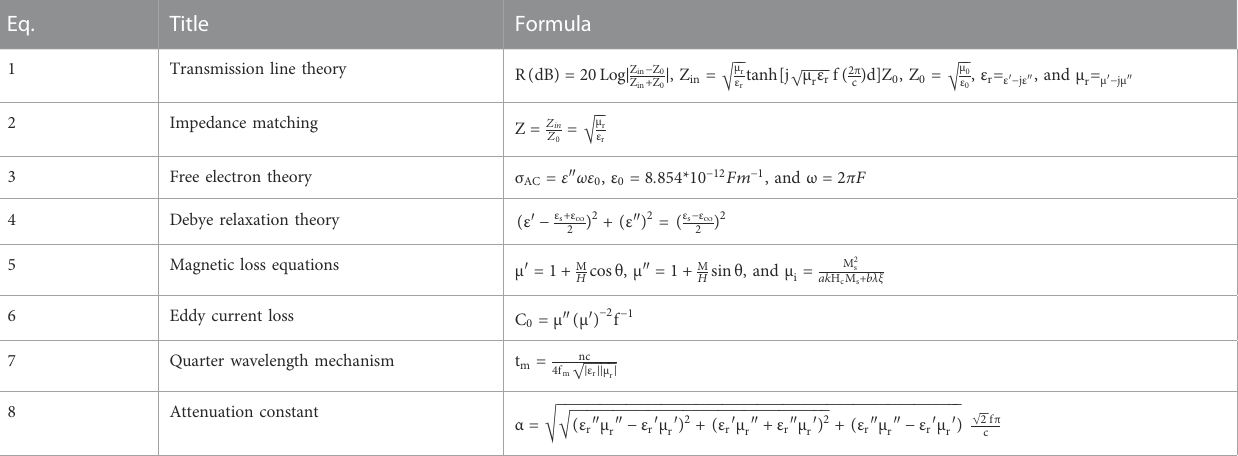
TABLE 2 Equations used to examine the electromagnetic wave-absorbing performance.